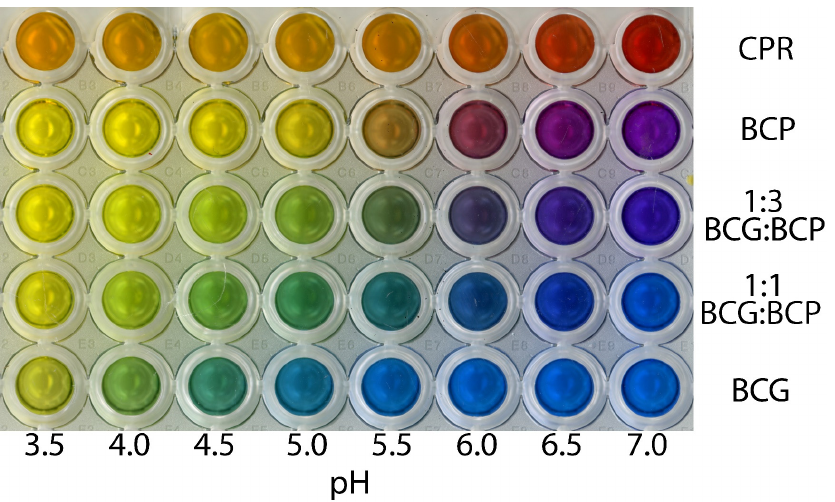
Figure 1. Colour change in chlorophenol red (CPR), bromocresol green (BCG), and bromocresol purple (BCP), as well as a 1:1 and 1:3 combination of BCG:BCP over a pH range of 3.5–7.0. Each well contains 200 µ L of the pH indicator at a concentration of 250 µ g mL − 1 in a 0.1 M phosphate buffered solution set to the corresponding